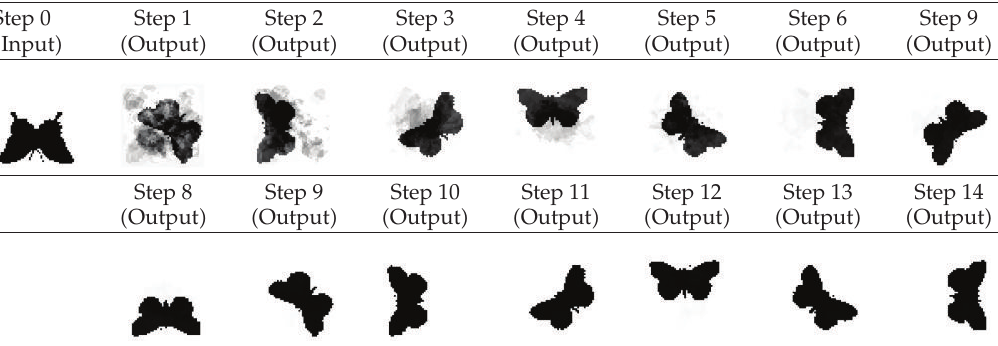
Table 9: Network recall using a di ff erent picture: another example of butterfly.